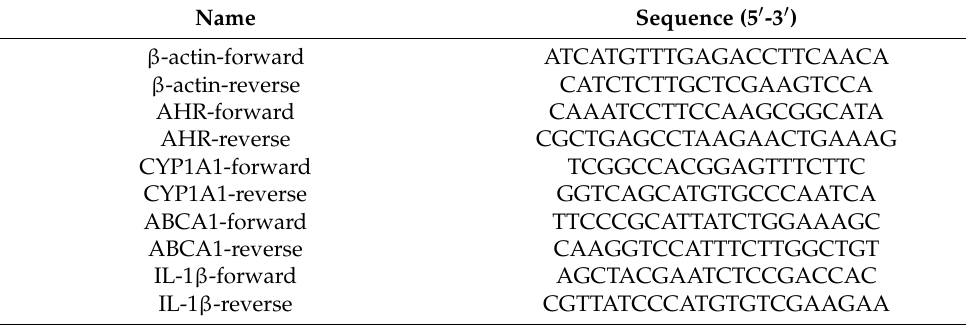
Table 1. Primers for real-time qPCR.